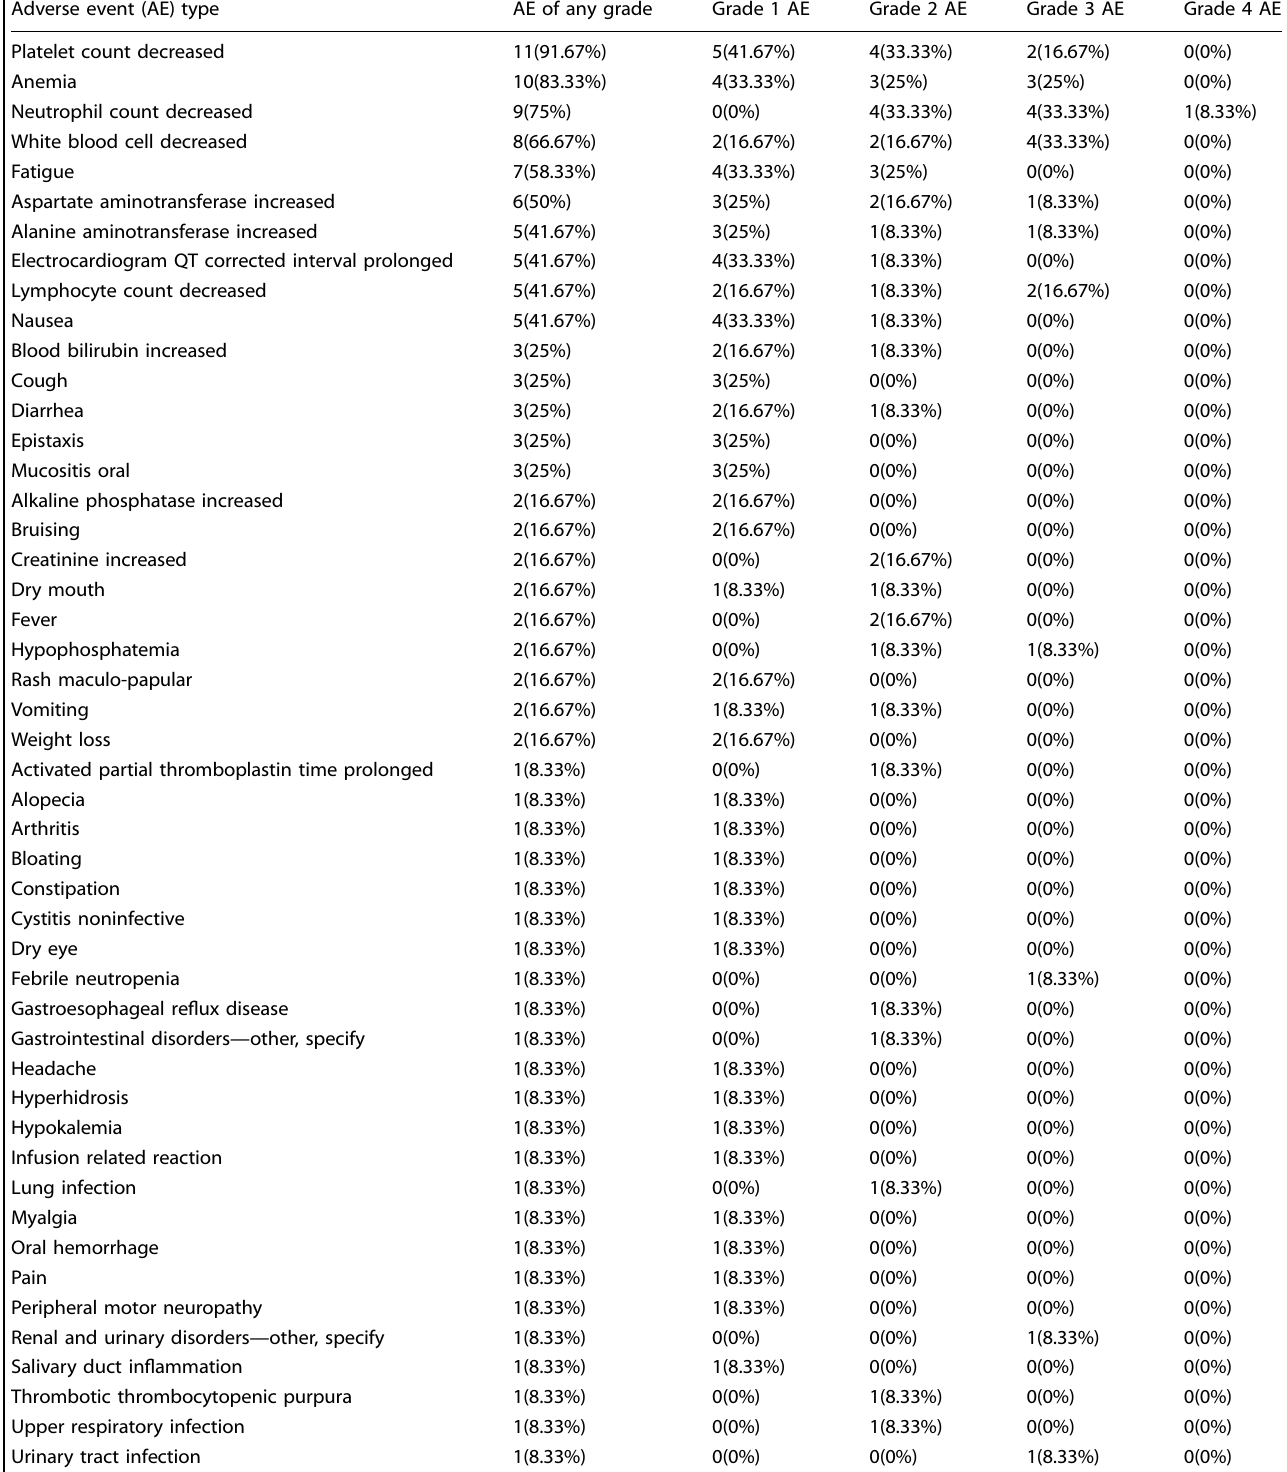
Table 2. Treatment-related adverse events